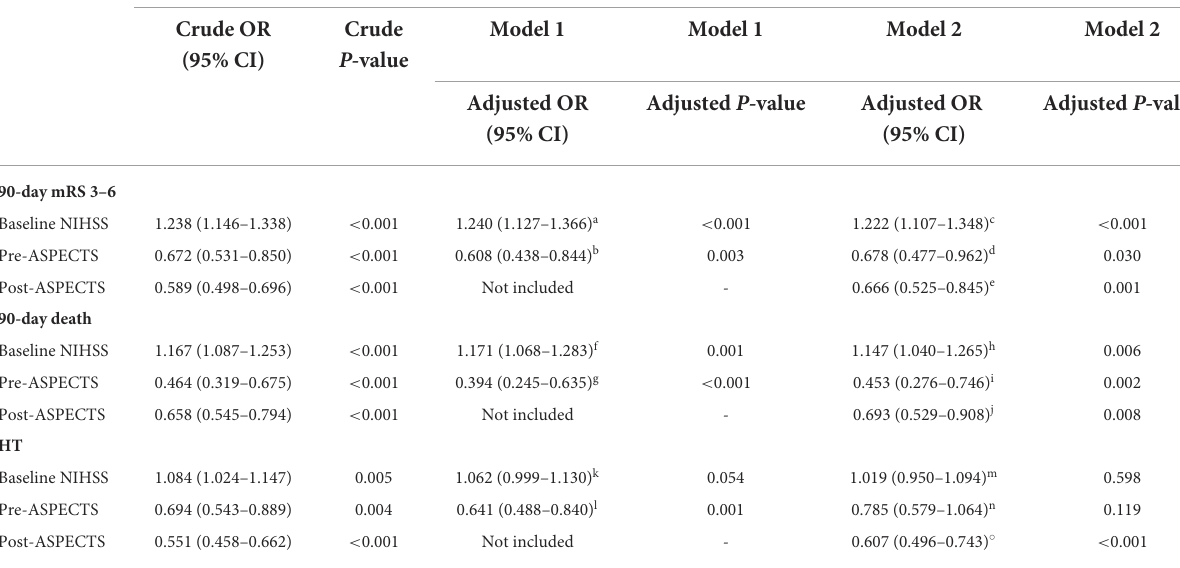
TABLE 3 Multivariable logistic regression analysis of 90-day poor prognosis, 90-day death, and HT.